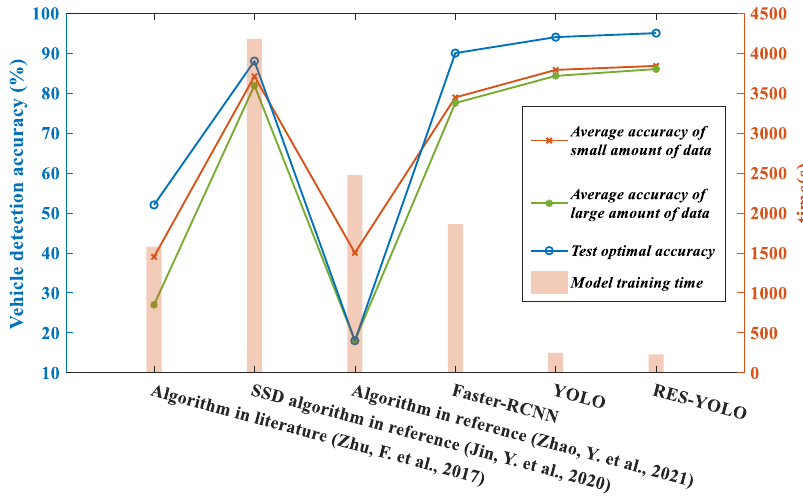
Figure 17. Actual test renderings of six types of networks [20 –